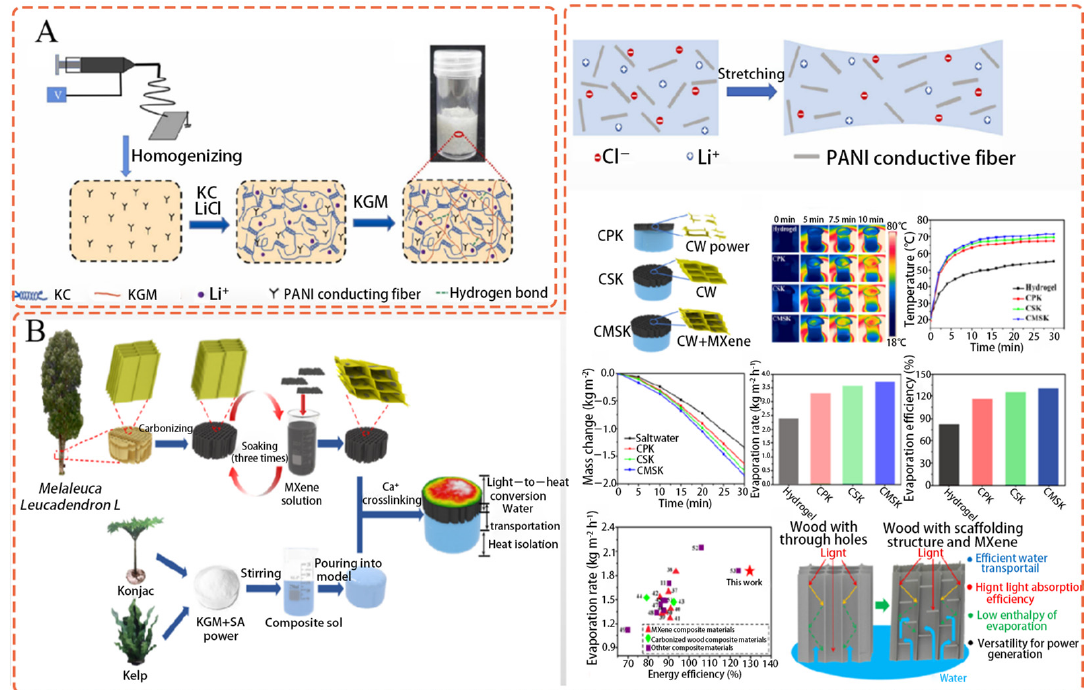
Figure 3. ( A ) Preparation mechanism of conductive hydrogel and schematic illustration of KKLN hydrogel during stretching (Adapted with permission from Ref. [114]. 2023, Elsevier); ( B ) Scheme of the fabrication for the multifunctional evaporator, and the structure, functionality, and working mechanism of the evaporators (Adapted with permission from Ref. [115]. 2023, American Chemical Society Elsevier).